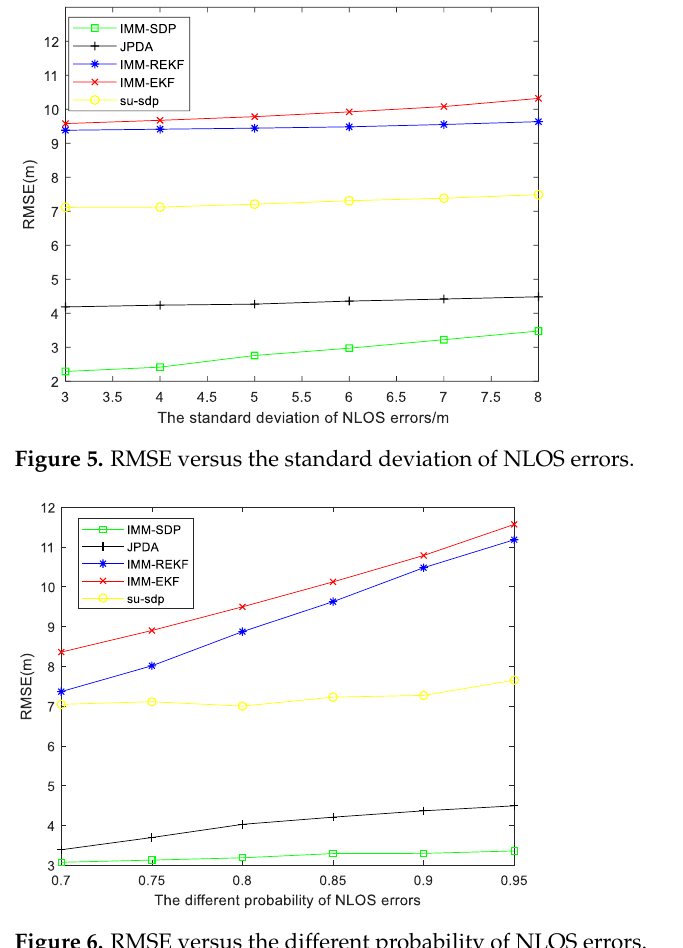
Figure 6. RMSE versus the different probability of NLOS errors.